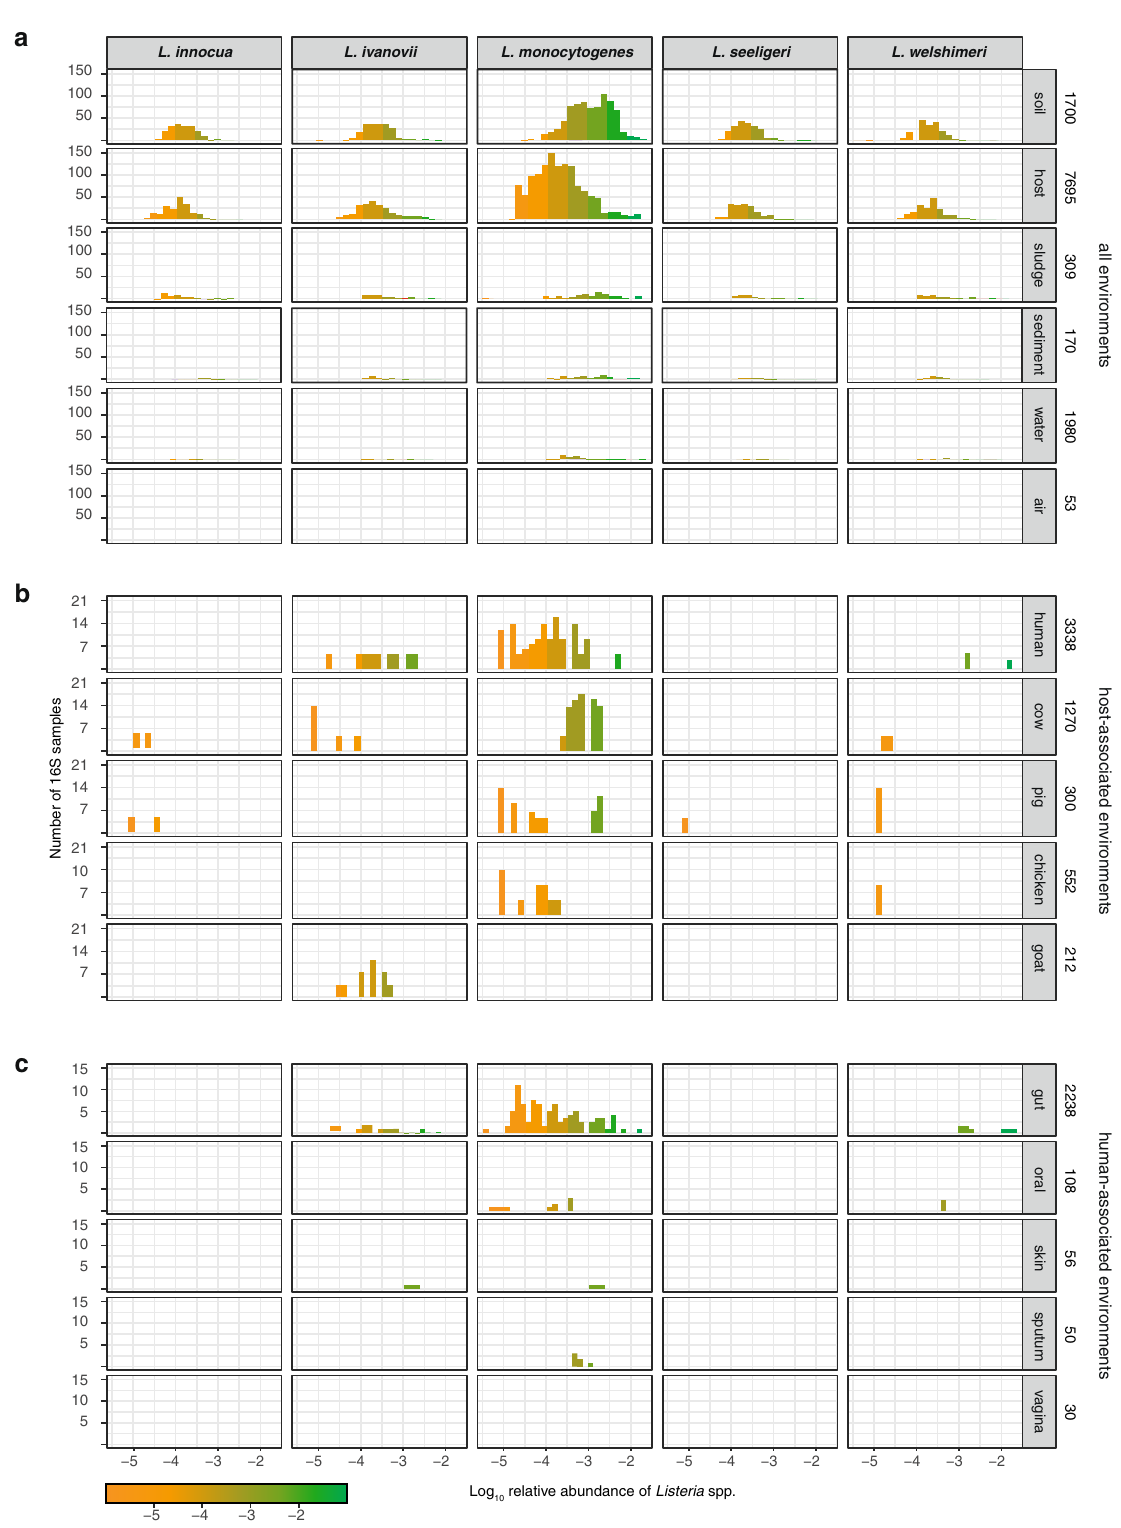
Fig. 1 Lm is more prevalent in host-associated environments than non-pathogenic Listeria species. Relative abundance and prevalence of Listeria sensu stricto species in 16S rRNA gene datasets in a different environments, b in selected host datasets (i.e. farm animals and/or known Lm reservoirs which were present >100x in our datasets) for which metadata detailing the host species were available and c from different sampling sites of healthy human hosts for which detailed metadata on body sampling site were available. Numbers on the right indicate samples per